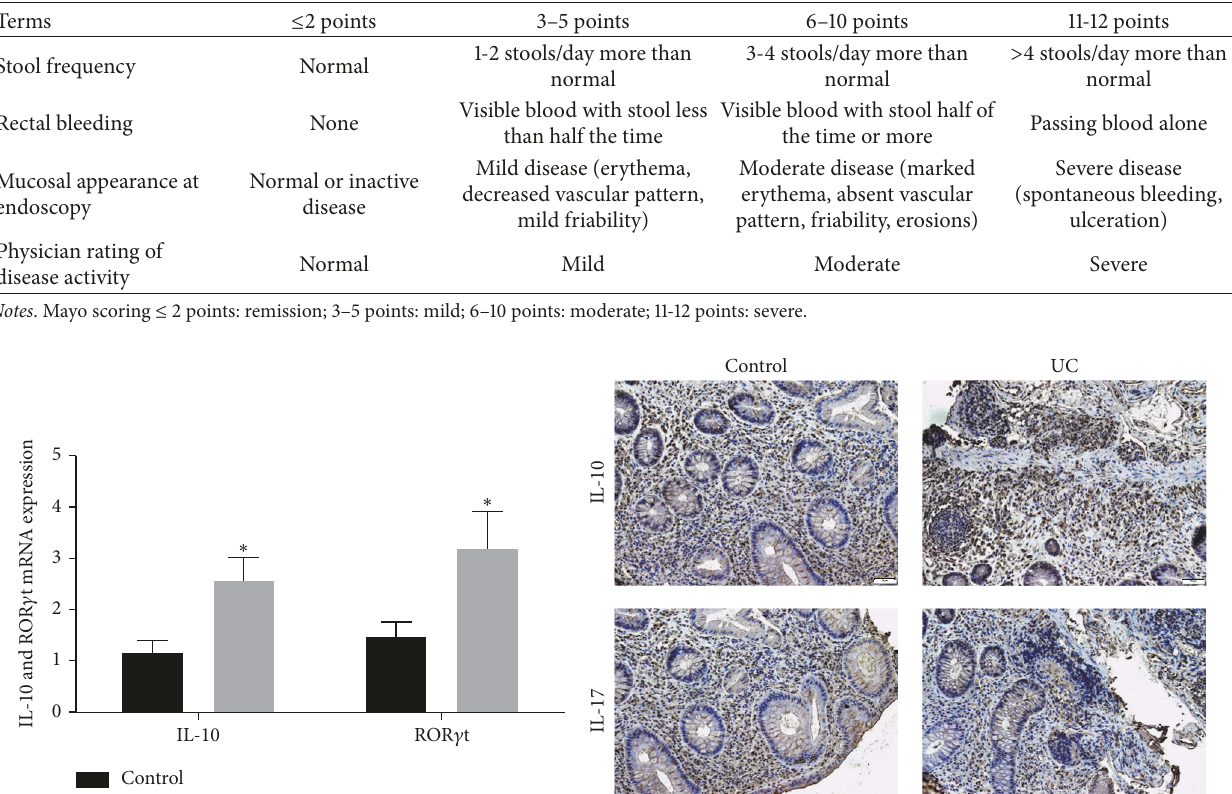
Table 1: Mayo score.